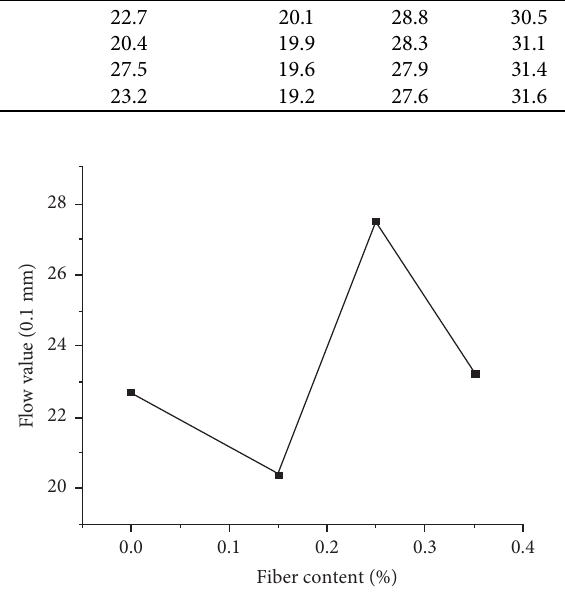
Figure 7: Relationship diagram of basalt fiber content and flow value.